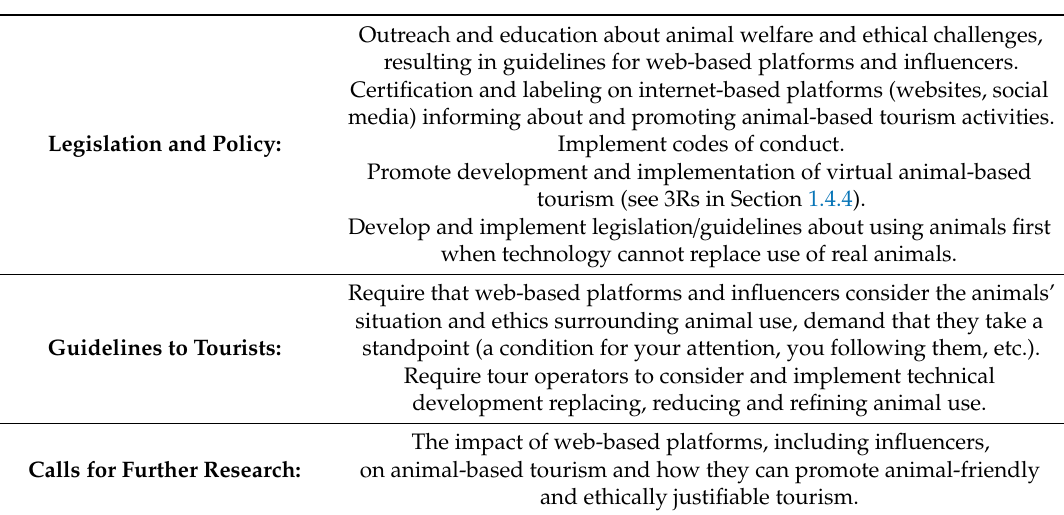
Table 3. Summary of workshop conclusions on legislation and policy, guidelines to tourists and calls for further research on the role of digital technology in animal-based